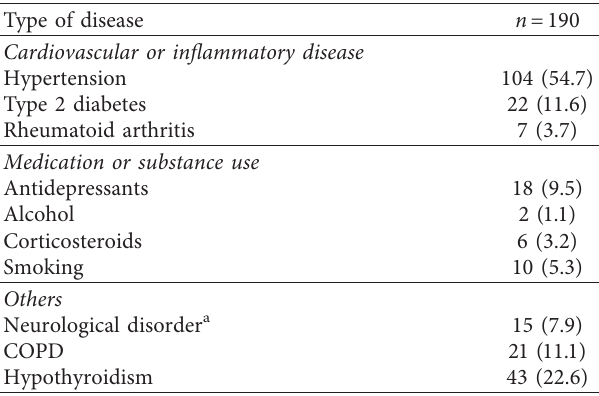
Figure 1: Postfracture care program and study flowchart. a Workup included laboratory testing and dual X-ray absorptiometry (DXA). Table 2: Patients’ comorbidities and fall risk